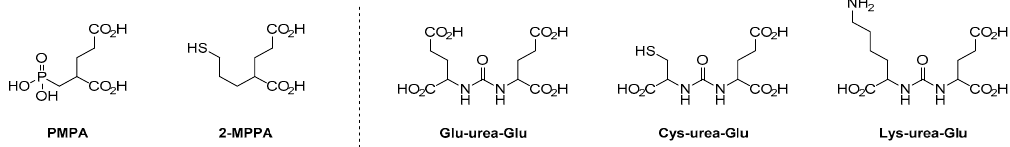
Figure 2. Structures of PSMA-binding entities: ( left ) the initially developed phosphorous-based PMPA and thiol-based 2-MPPA; ( right ) urea-based entities, including the most successfully applied entity, Lys–urea–Glu. All entities comprise a Zn(II) coordinating moiety and glutamic acid.